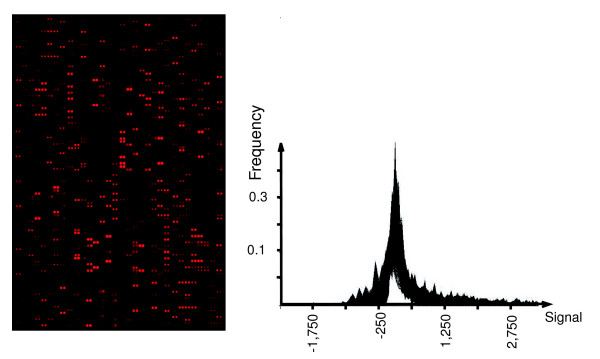
A representative protein microarray with high-quality data. The slide image was reconstructed from a protein microarray experiment with minimal noise in the data. Density plots of signals in local 37 by 37 windows (window size 9) for all spots were computationally combined, and they showed high similarities.